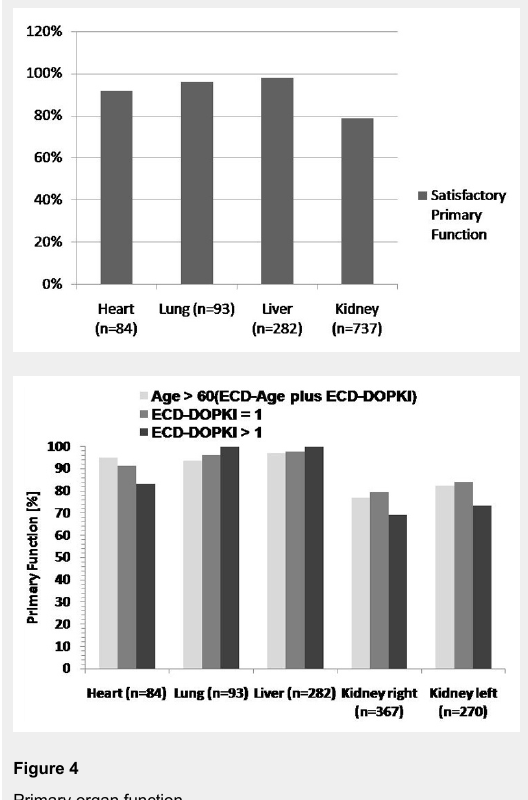
Primary organ function. Percentage of primary organ function in ECD with ECD ≥60 years, ECD ≥65 years and ECD ≥70 years (derived from ECD-Age and ECD-DOPKI), ECD-DOPKI=1 and ECD-DOPKI>1, separate for every